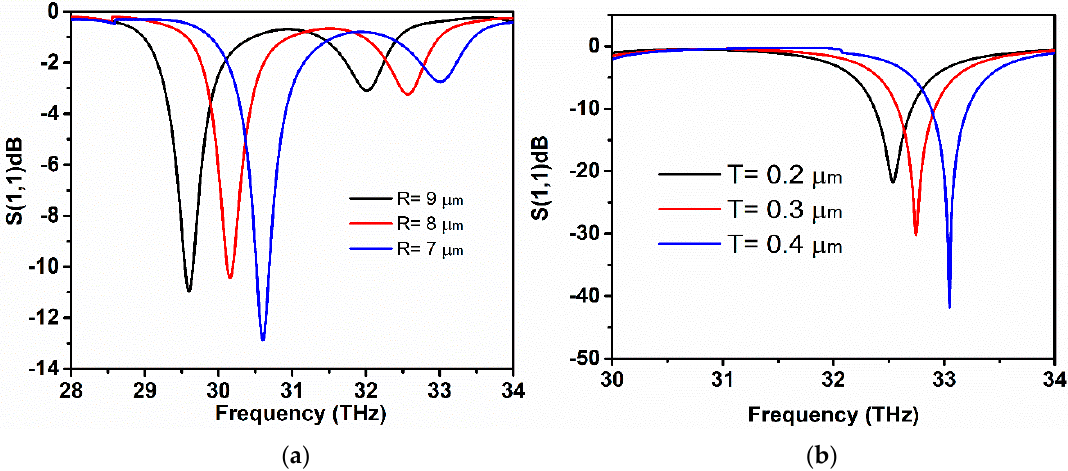
Figure 8. ( a ) S 11 with respect to the increasing size of the gold hexagon; and, ( b ) Resonance tuning of the proposed antenna by decreasing the thickness of the metallic layer.